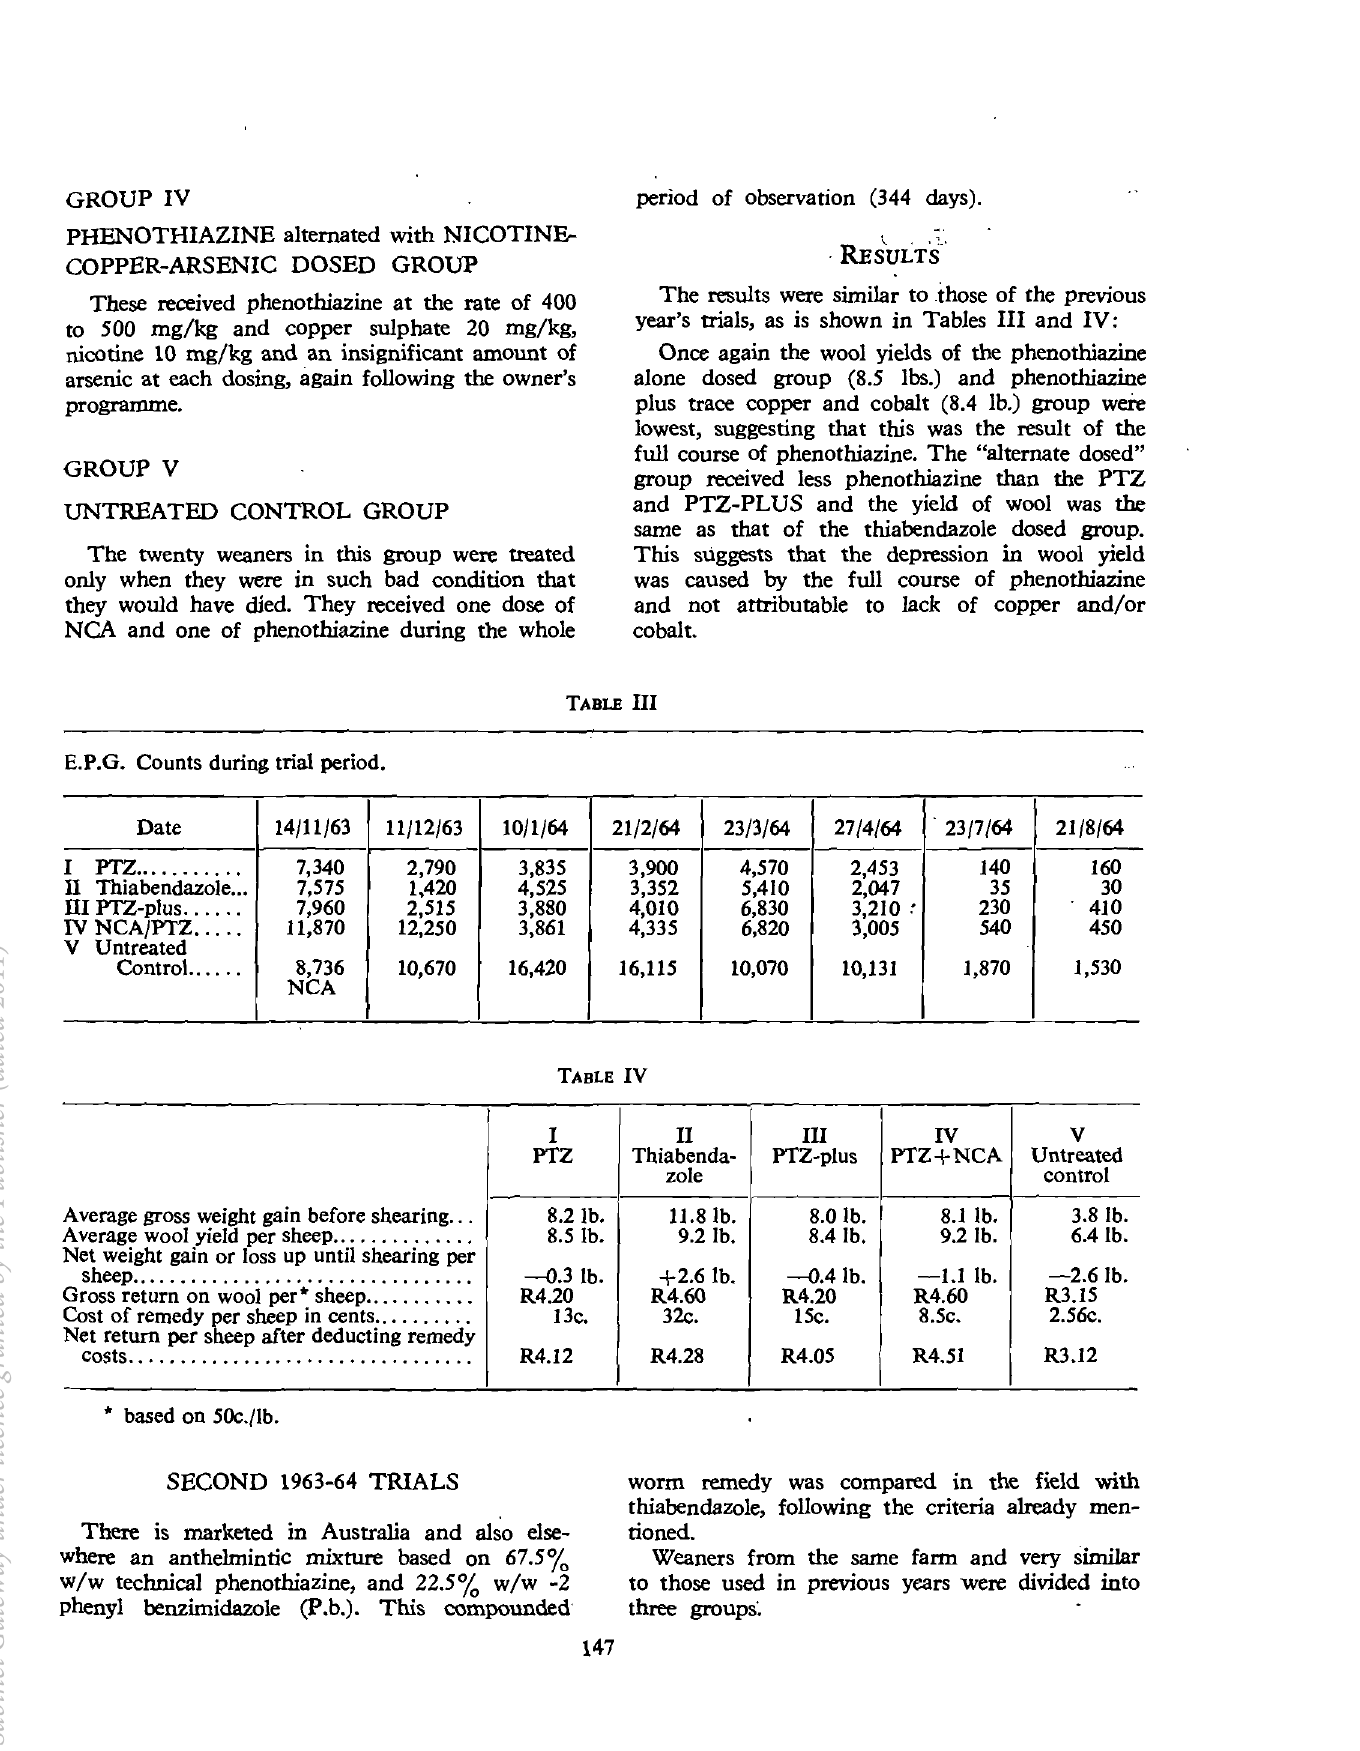
Average gross weight gain before shearing